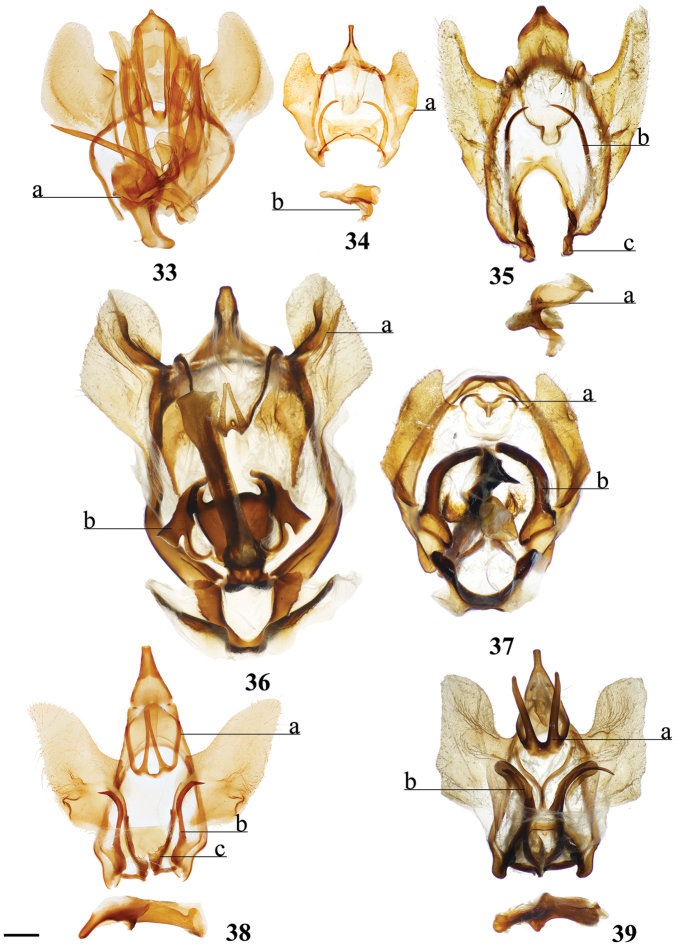
Ventral view of male genitalia of type species of genera belonging to Cicinninae: Cicinnini. Phallus/juxtal complex, when excised, is figured below the genitalia in the lateral view. 33Aceclostriamus, St Laurent diss.: 10-8-14:2 (CUIC) 34Aleydaaccipiter, genitalia preparation and photo by T Malm, diss.: NHRS-TOBI 000001871 [reused with permission from St Laurent et al. (2018b), SHILAP) (NHRS) 35Euphanetadivisa, St Laurent diss.: 3-17-18:1 (MGCL) 36Cicinnuscforthane, St Laurent diss.: 10-30-17:1 [reused with permission St Laurent et al. (2018c), Zootaxa] (MGCL) 37Arcinnushoedli, St Laurent diss.: LEP20643 (MGCL) 38Isoscellaventana, St Laurent diss.: 4-29-16:2 [reused with permission from St Laurent and Carvalho (2017b), Journal of the Lepidopterists’ Society] (USNM) 39Roelmanamaloba, St Laurent diss.: 3-22-18:1 (MGCL). Scale bar: 1 mm.